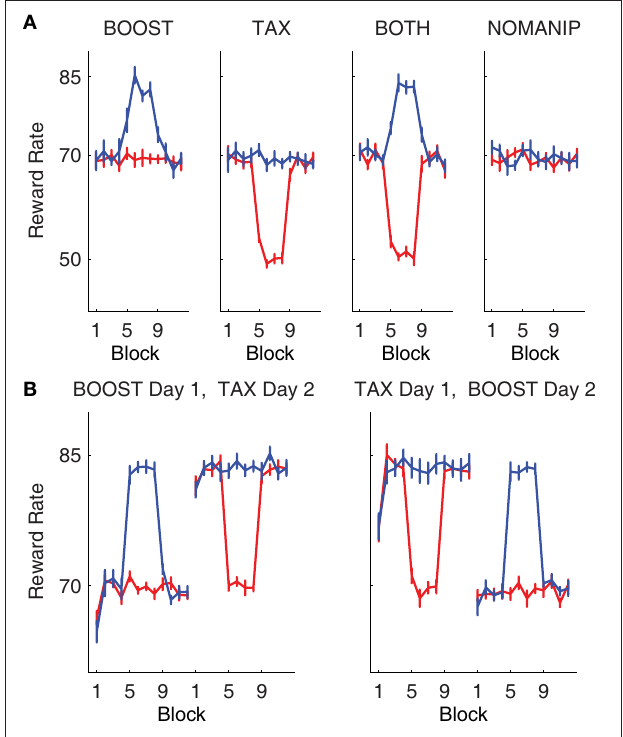
Figure 2 | Observed rewards rates for the right hand (red) and left hand (blue). Target reward rate was fixed for Blocks 1–4 (baseline), adjusted in Blocks 5–8 (manipulation), and then returned to the initial rates in Blocks 9–12 (post-manipulation). (A) Experiment 1 reward rates for the four experimental conditions (BOOST: increase reward rate for left hand, TAX: decrease reward rate of right hand, BOTH: both tax and boost manipulations, NOMANIP: no manipulation). (B) Experiment 2 reward rates for the two experimental conditions and two subjects